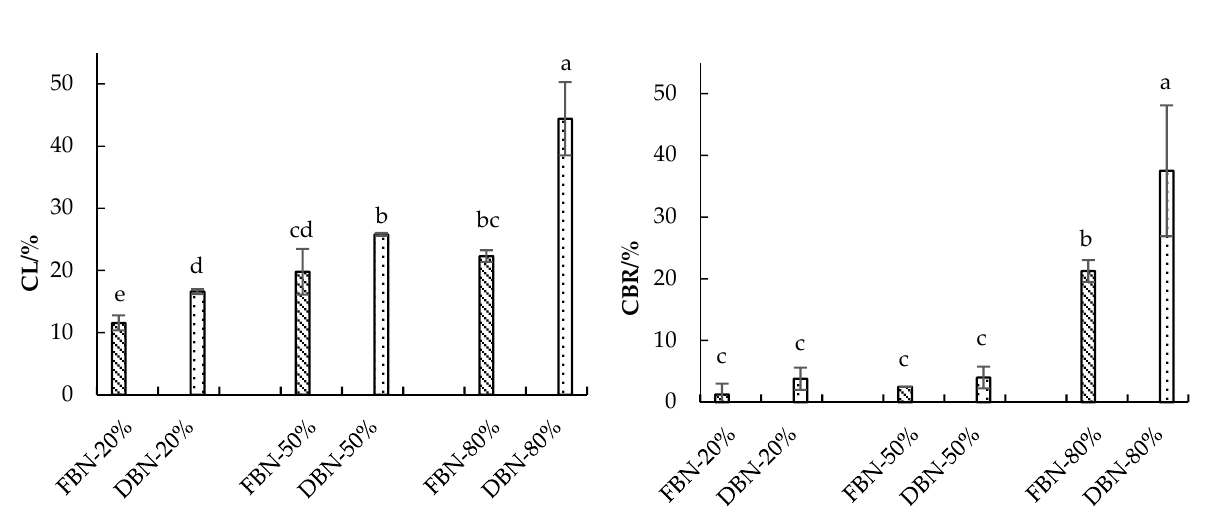
Figure 1. Cooking loss (CL) and cooking breakage ratio (CBR) of FBN and DBN. FBN-20/50/80% is fresh buckwheat noodles with 20/50/80% of extruded buckwheat flour; DBN-20/50/80% is dried buckwheat noodles with 20/50/80% of extruded buckwheat flour; a, b, c, and d indicate values are significantly different at p < 0.05.